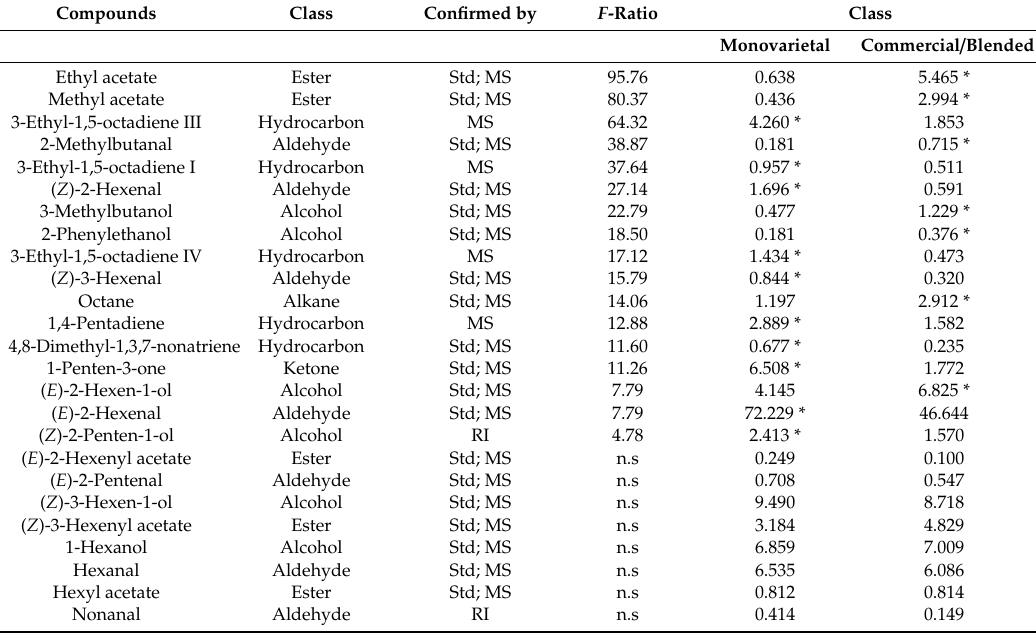
Table 1. List of volatile aroma compounds found in monovarietal Protected Designation of Origin (PDO) and commercial-blended extra virgin olive oils by headspace solid-phase microextraction combined with gas chromatography / mass spectrometry (HS-SPME-GC-MS) sorted by descending Fisher F -ratio, compound class, type of identification, and semi-quantitative values in mg / kg relative to internal